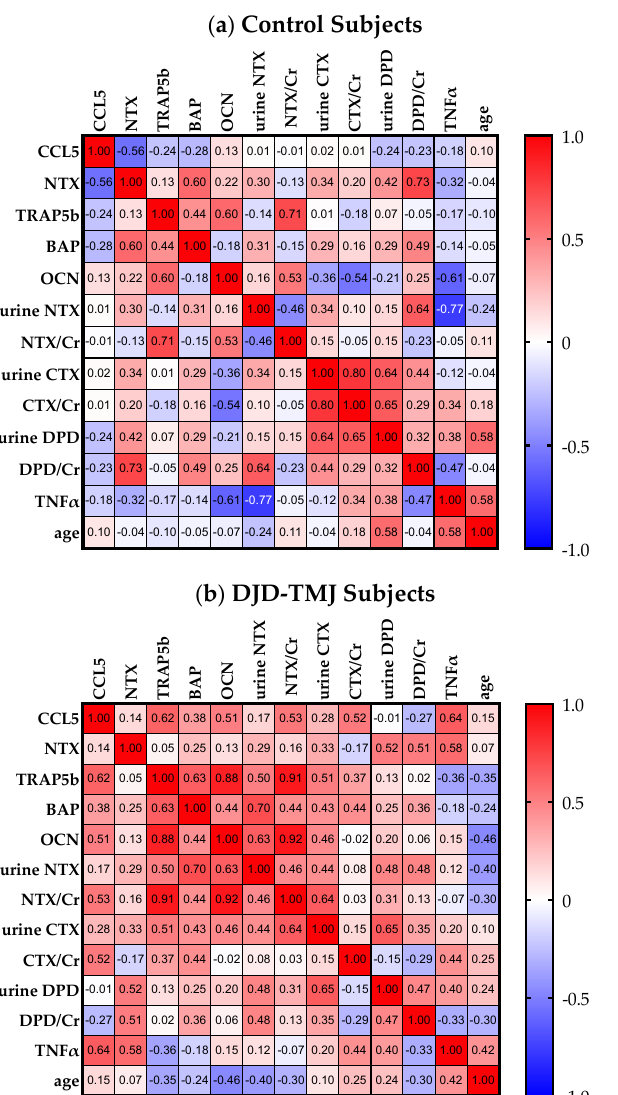
Figure 2. Multivariate analyses between molecules in ( a ) the control groups (n = 17) and ( b ) the group of all DJD-TMJ subjects (n = 17). The color depth of red and blue indicates the degree of positive and negative associations, respectively, between indicated molecules.